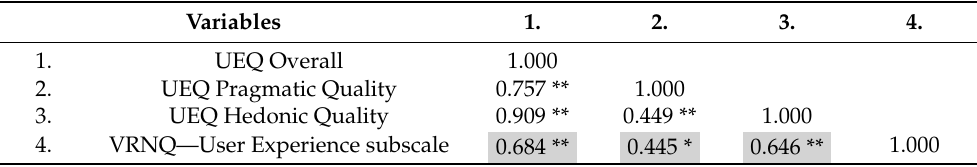
Table 14. Correlation matrix for LA_RFG condition—Spearman ( ρ ) correlation coefficients for combined user experience measures ( n =